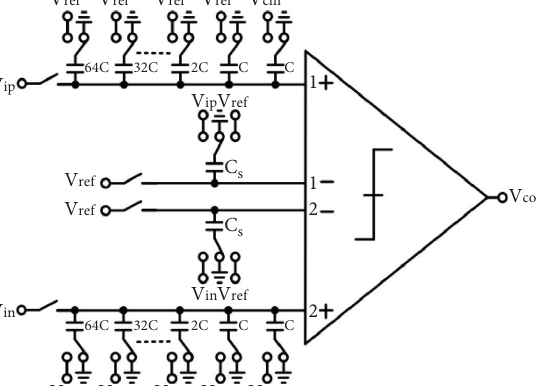
Figure 21: Te dual sampling technique